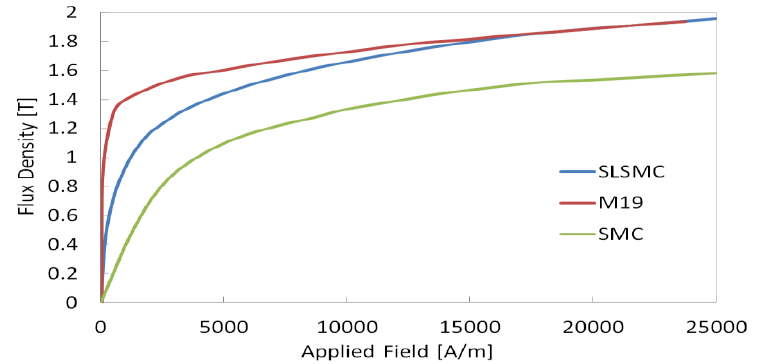
Figure 7. Magnetic saturation behavior of the flux density with different core materials [10].